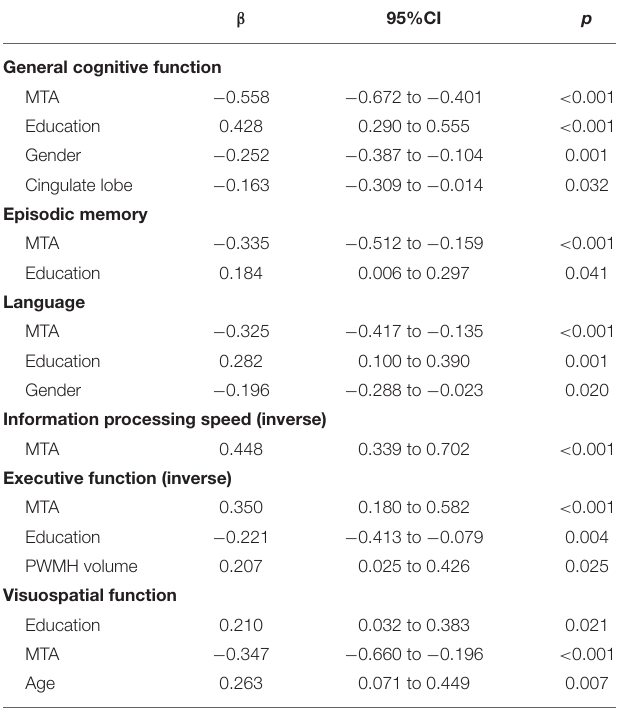
TABLE 2 | Multiple linear regression analysis for cognitive function in CSVD-CI group ( n = 135). β 95%CI